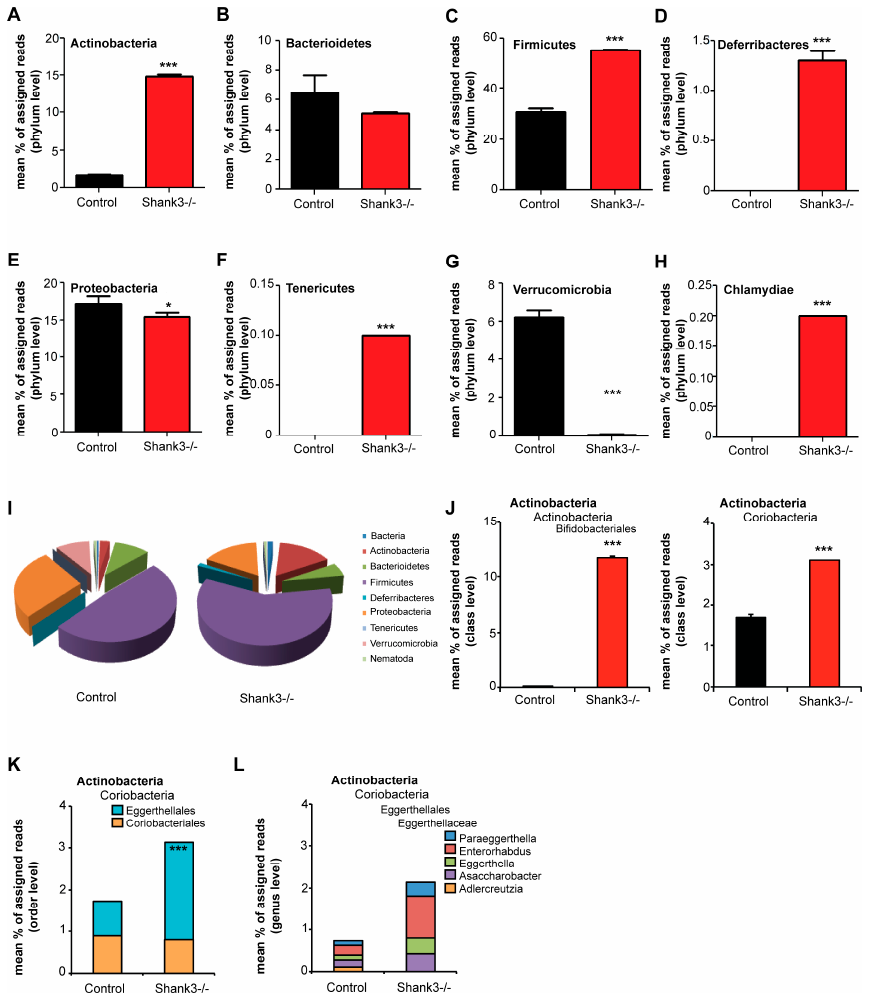
Figure 3. Altered microbiome in Shank3 αβ KO mice. DNA was extracted from feces from 10 weeks old animals and microbiome analysis was performed using 16S Microbiome Profiling. Feces from four di ff erent animals were pooled per sample and three samples per group were analyzed. ( A ) The amount of Actinobacteria is significantly higher in feces from Shank3 αβ KO mice. ( B ) The amount of Bacterioidetes is not significantly di ff erent between control and Shank3 αβ KO mice. ( C ) A significant increase in Firmicutes was found in Shank3 αβ KO mice. ( D ) Bacteria of the phylum Deferribacteres were only found in Shank3 αβ KO mice. ( E ) Significantly reduced levels of Proteobacteria were detected in Shank3 αβ KO mice. ( F ) Bacteria of the phylum Tenericutes were only found in Shank3 αβ KO mice. ( G ) The amount of Verrucomicrobia was significantly lower in Shank3 αβ KO mice. ( H ) Bacteria of the phylum Chlamydiae were only found in Shank3 αβ KO mice. ( I ) Overview of the identified relative frequencies of di ff erent phyla found in control and Shank3 αβ KO mice. ( J ) The increase in Actinobacteria is caused by a significant increase in both classes Actinobacteria (order Bifidobacteriales ) ( t -test, p < 0.0001) and Coriobacteria ( t -test, p < 0.0001). ( K ) Coriobacteria increase due to a significant higher levels in the order Eggerthellales , but not Coriobacteriales . ( L ) Within the family Eggerthellaceae, Adlercreutzia did not show an increase. The genera Asaccharobacter, Eggerthella, Enterorhabdus, and Paraeggerthella show significant increase. * p < 0.05, *** p <